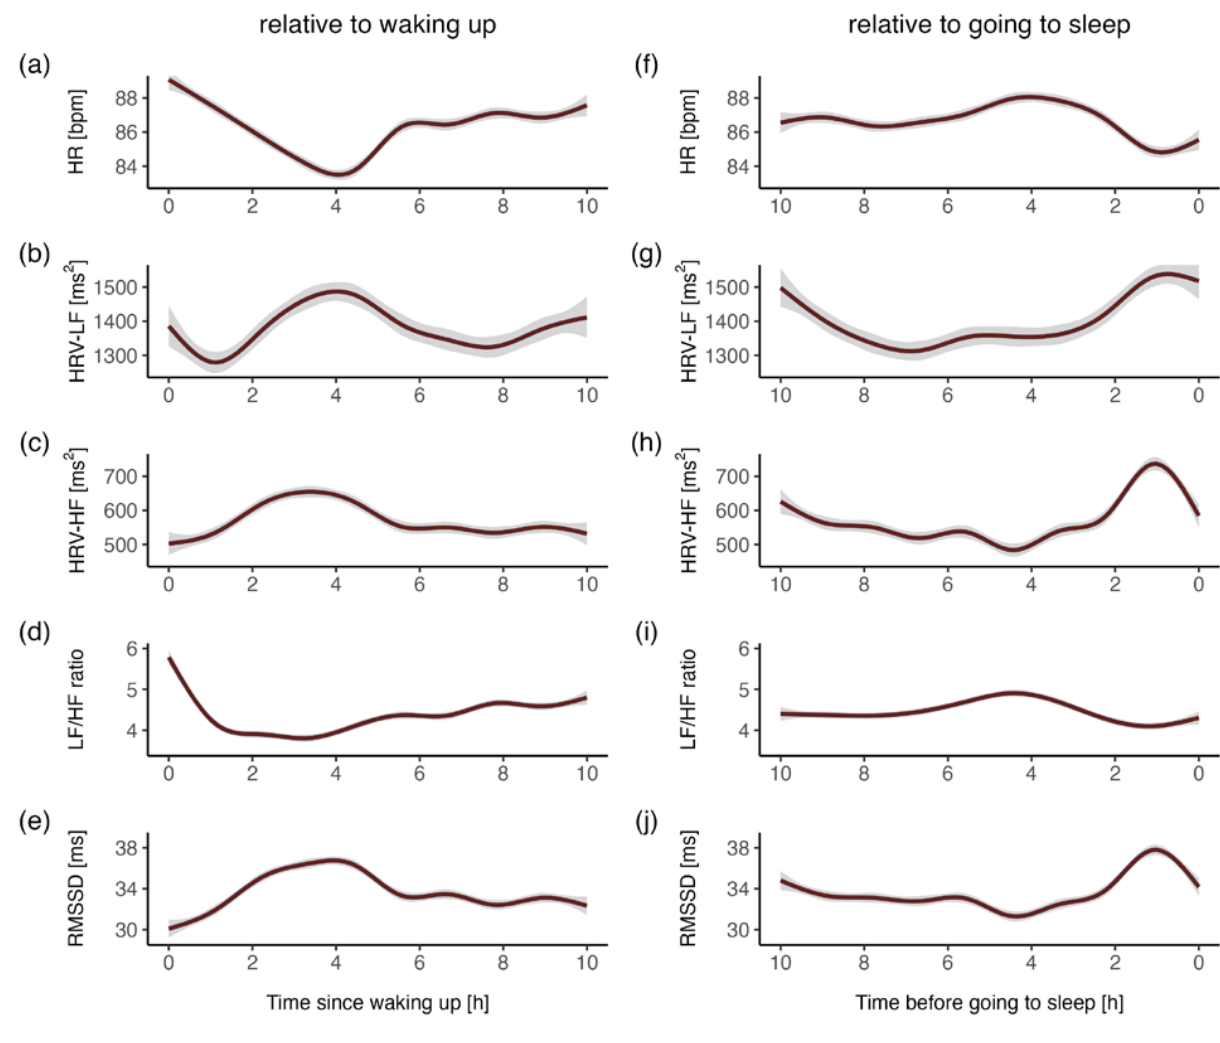
Figure 2. Diurnal variations in the HR and HRV indices ( a – e ) relative to waking up (start of wear time) and ( f – j ) relative to going to sleep (end of wear time). ( a , f ) HR, heart rate; ( b , g ) HRV-LF, low-frequency power; ( c , h ) HRV-HF, high-frequency power; ( d , i ) LF/HF ratio, ratio of low- to high-frequency power; ( e , j ) RMSSD, root-mean-square of successive differences. The indices were averaged across all individuals and days.